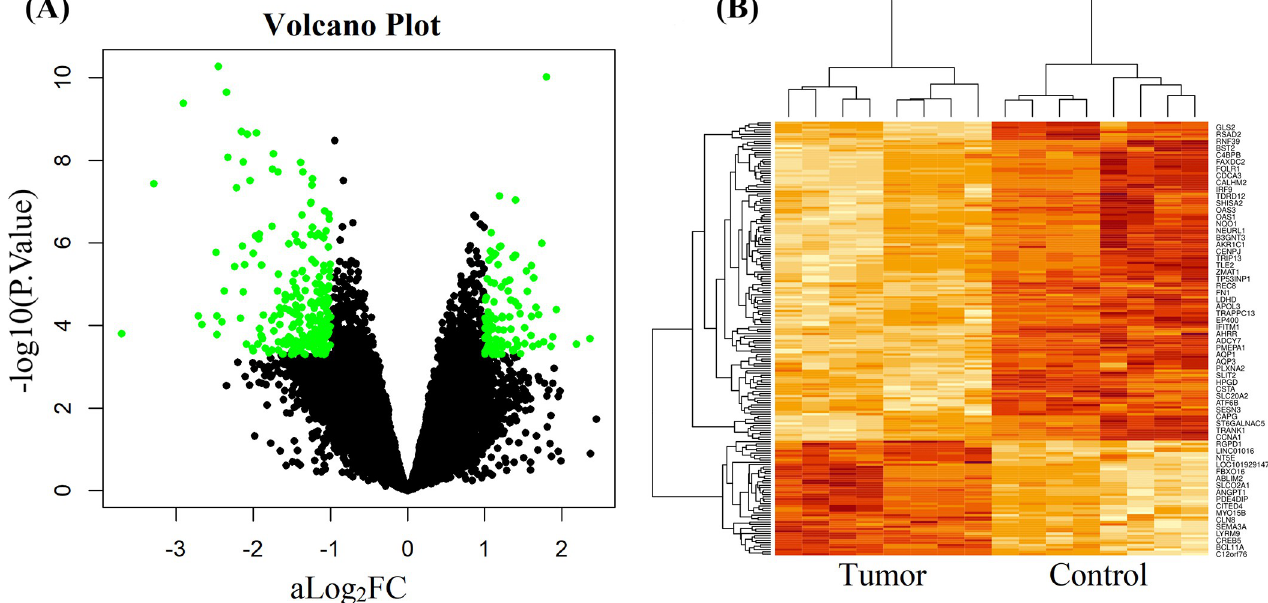
Fig 2. (A) Volcano plot of–log 10 ( P -value) against log 2 FC values to display significantly upregulated and downregulated DEGs. (B) Heatmap of significantly upregulated and downregulated DEGs to observe the clustering performance of tumor and control groups by hierarchical clustering approach.